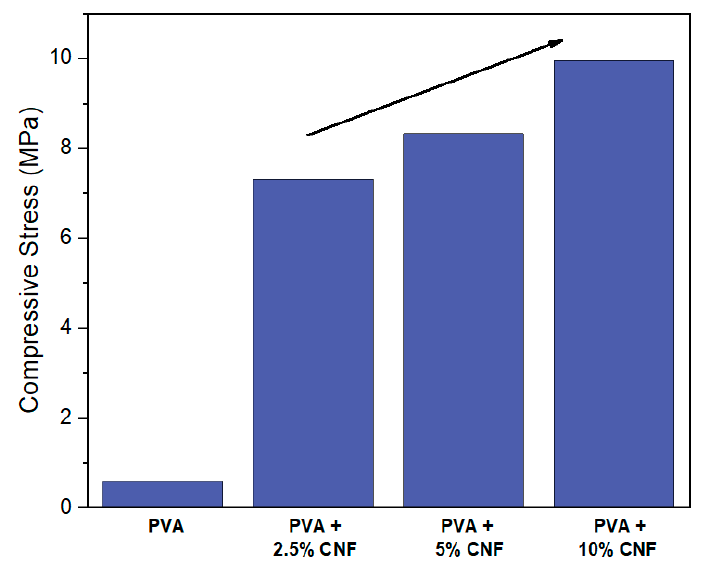
Figure 3. Compressive stress of prepared PVA/CNF